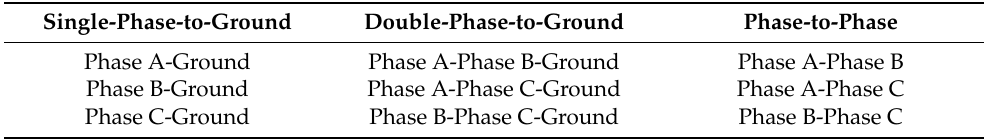
Table 1. Breakdown of the simulated faults.